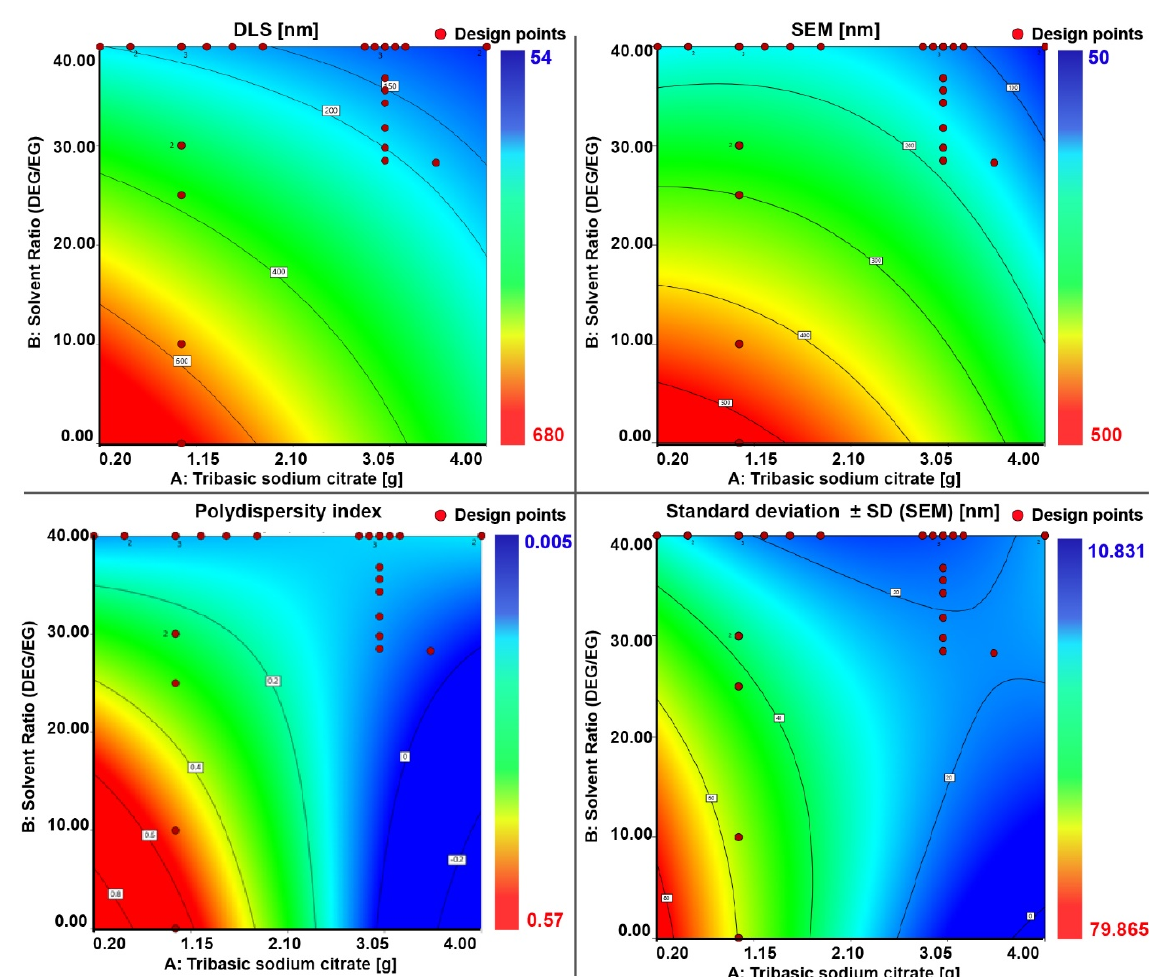
Figure 6. Contour plot for the four responses. The different colors represent different sizes. It is indicated with a specific color which size can be obtained for a specific combination of a certain citrate amount and solvent ratio. The design points represented on the color map represent the experiments we actually performed.